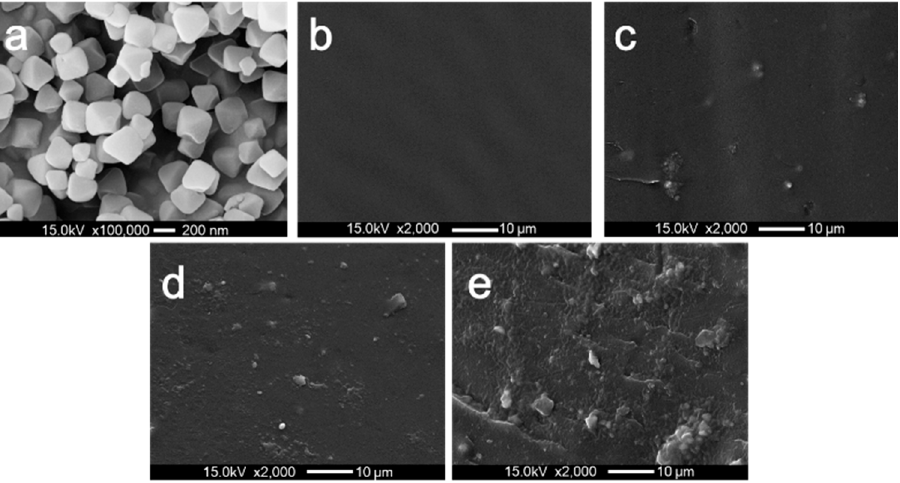
Figure 2. SEM image of PET and PET/UIO-66 nanocomposites: ( a ) UIO-66; ( b ) neat PET, ( c ) PET- UIO66-0.5; ( d ) PET-UIO66-1 and ( e ) PET-UIO66-3.